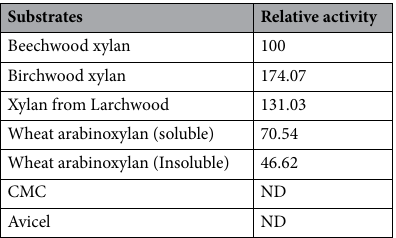
Table 10. Substrate specificity of the purified xylanase. Each data point represents mean ± SD (n = 3) ND is not detected.